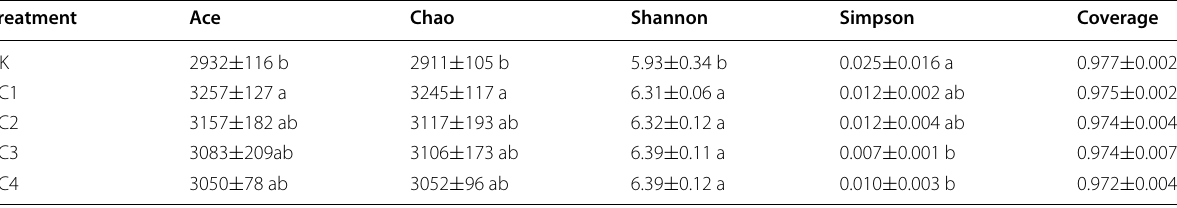
Table 2 Effects of biochar application rates on the alpha diversity of the bacterial community